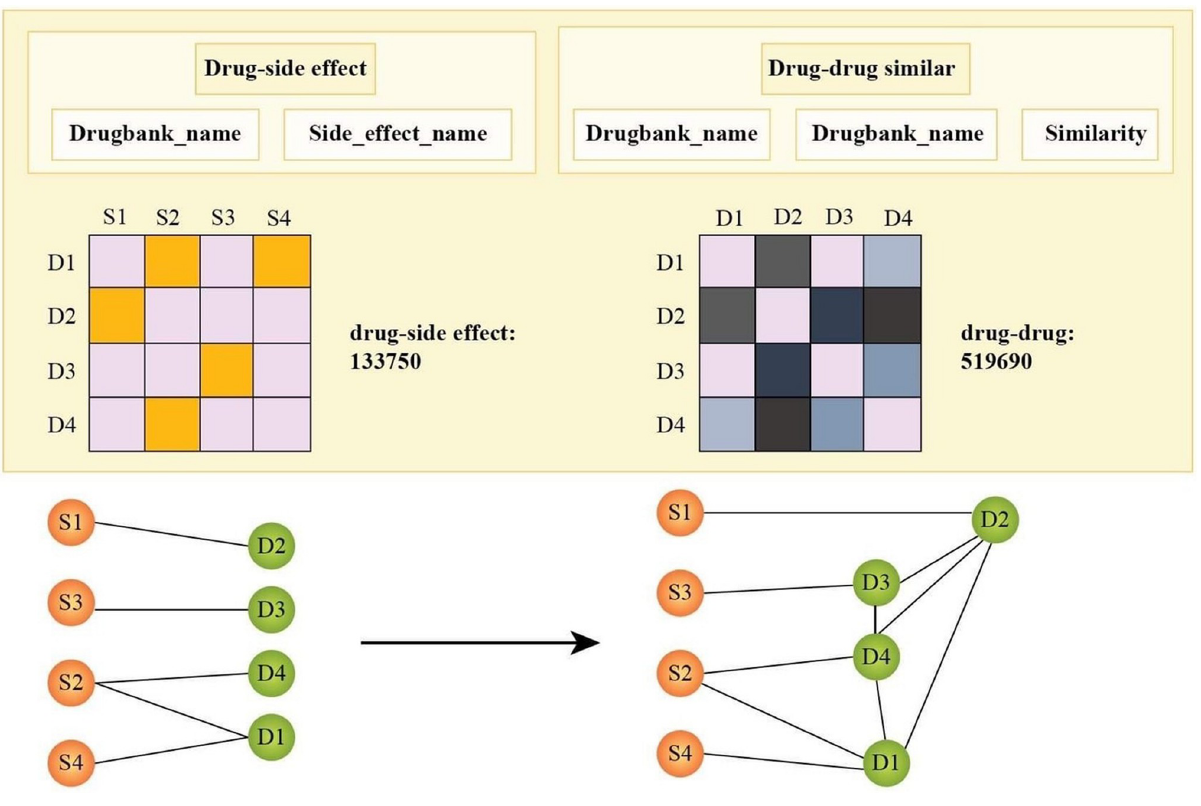
Fig 1. The illustration of the combination of